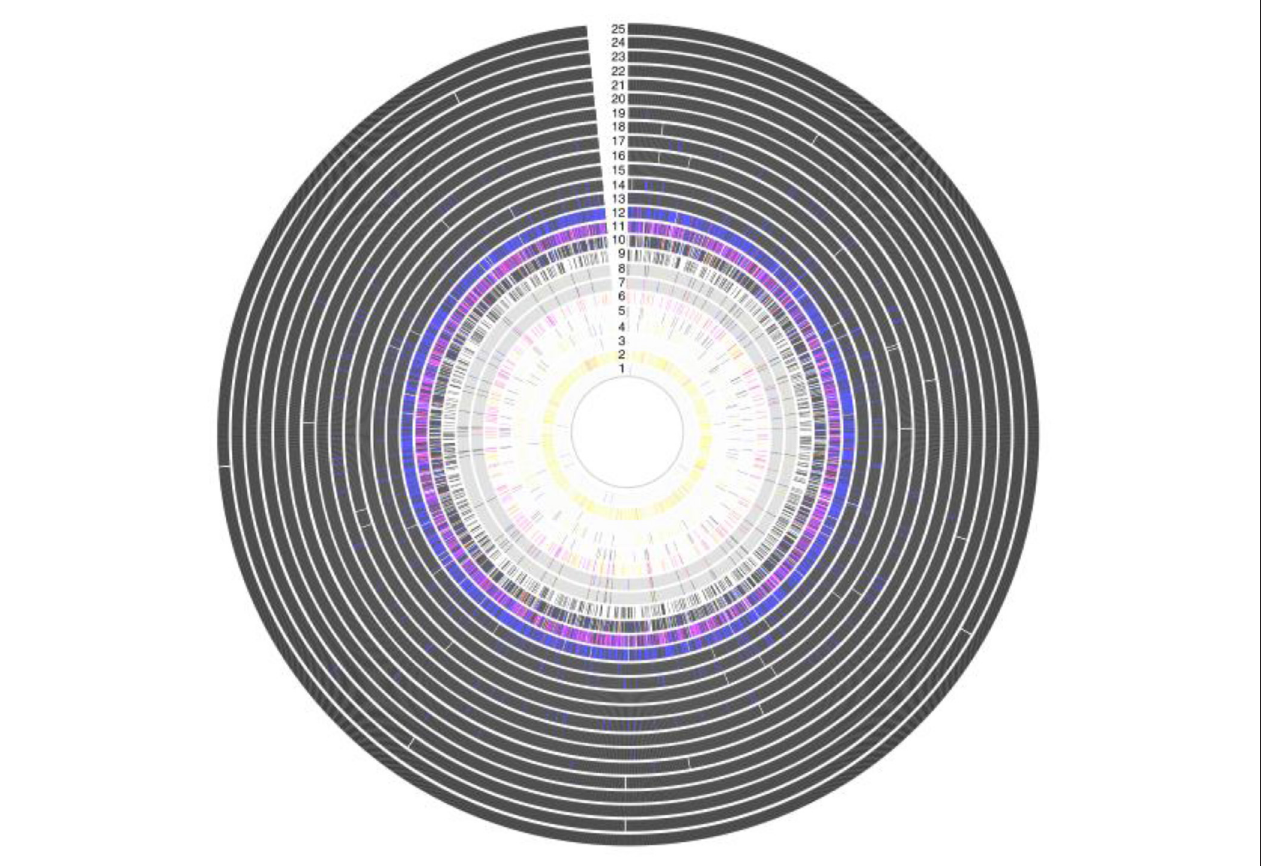
FIGURE 5 | Antigenic variation within vaccine targets, showing a high grade of variation in Amino acid sequence within 25 protein antigens. Each ring represents a single antigen with protein similarity color coded according to pairwise BLASTp similarity: black ( > 98%); blue (95–98%); red (90–95%); pink (80–90%); yellow (70–80%); gray ( < 70%); and white (protein absence). Rings correspond to: (1) R28; (2) Sfb1; (3) Spa; (4) SfbII;(5) FbaA; (6) SpeA; (7) M1 (whole protein); (8) M1 (180-bp N terminal); (9) SpeC; (10) Sse; (11) Sib35; (12) ScpA; (13) SpyCEP; (14) PulA; (15) SLO; (16) Shr; (17) OppA; (18) SpeB; (19) Fbp54; (20) SpyAD; (21) Spy0651; (22) Spy0762;(23) Spy0942; (24) ADI; and (25) TF (